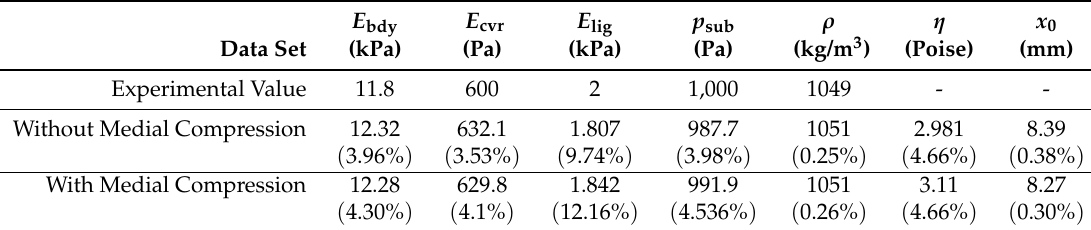
Table 4. Estimates and the associated uncertainties as a percentage of the estimate values (in brackets) for material properties of the silicone vocal folds and initial position for cases with and without medial compression ( p sub =